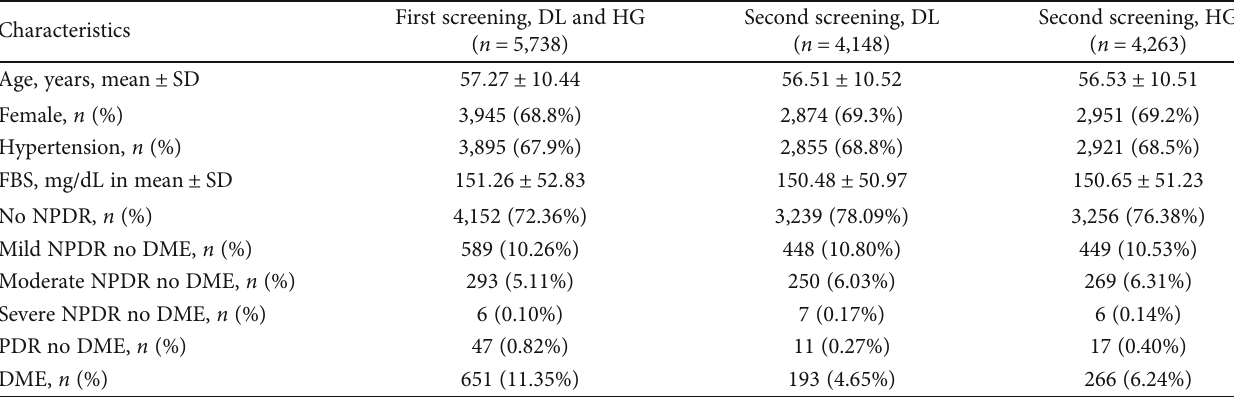
Figure 1: Flow of patients from the fi rst to the second screening. The number of patients in the cohorts of deep learning (DL) and trained human graders (HG) is compared at each point of the screening. The reference standard for these cases was based on an overread by retina specialists (Methods). Screen positive/negative indicates patients whom the DL or HG indicated as positive/negative. In this simulated setting, only patients who were con fi rmed by retina specialists to have STDR (i.e., true positives) were referred for treatment. The remaining patients were entered into the second screening. Dropout before the second screening included patients with missing data in either DL or HG or determined as ungradable by the reference standard during the second screening. Table 1: Demographic characteristics of patients with diabetes in the fi rst and second screening, including the prevalence of each diabetic retinopathy severity level and diabetic macular